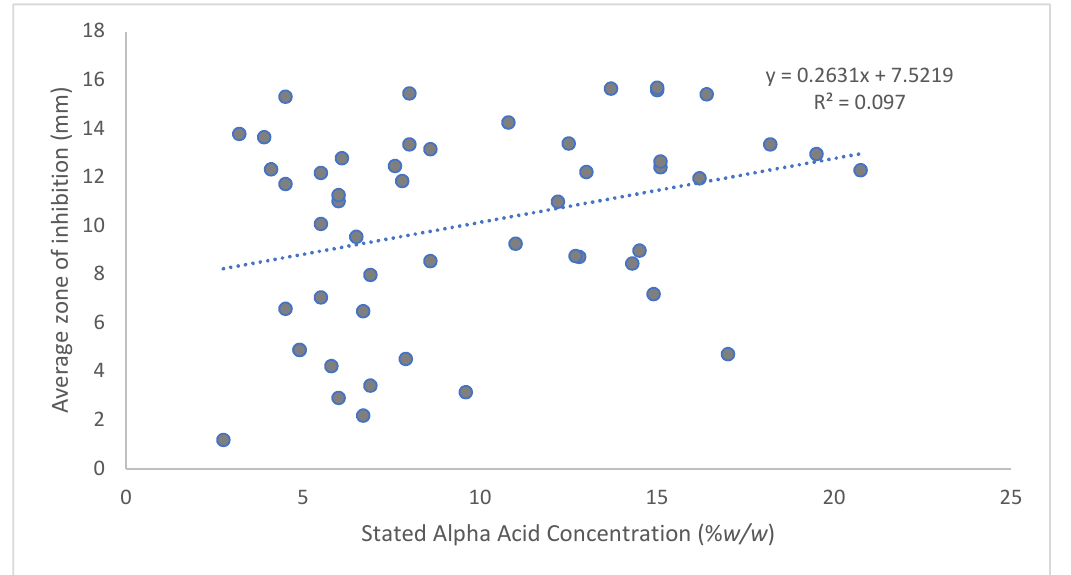
Figure 2. Correlation of the average zone of inhibition against M. bovis BCG and the stated alpha acid content of the hop variants.